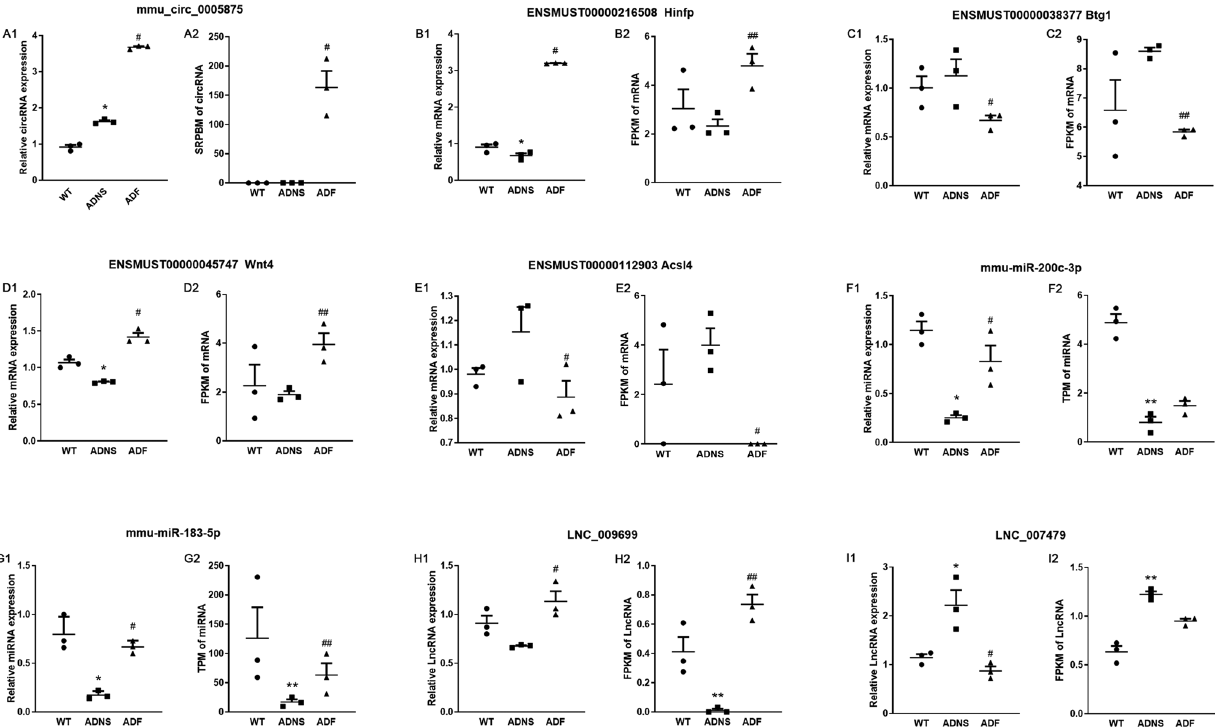
Figure 6. Validation of Differentially Expressed RNAs in hippocampal tissues from mice in each group. ( A ) Expression changes for select circRNA using RT-PCR (left) and high-throughput sequencing results (right) among WT, ADNS, and ADF samples. (B–E) Expression changes for select mRNAs using RT-PCR (left) and high-throughput sequencing results (right) among WT, ADNS, and ADF samples. (F,G) Expression changes for select miRNA using RT-PCR (left) and high-throughput sequencing results (right) among WT, ADNS, and ADF samples. (H,I) Expression changes for select lncRNAs using RT-PCR (left) and high-throughput sequencing results (right) among WT, ADNS, and ADF samples. * p < 0.05, ** p < 0.01 versus WT; # p < 0.05, ## p < 0.01 versus ADNS. The Dunnett’s test were used for statistical